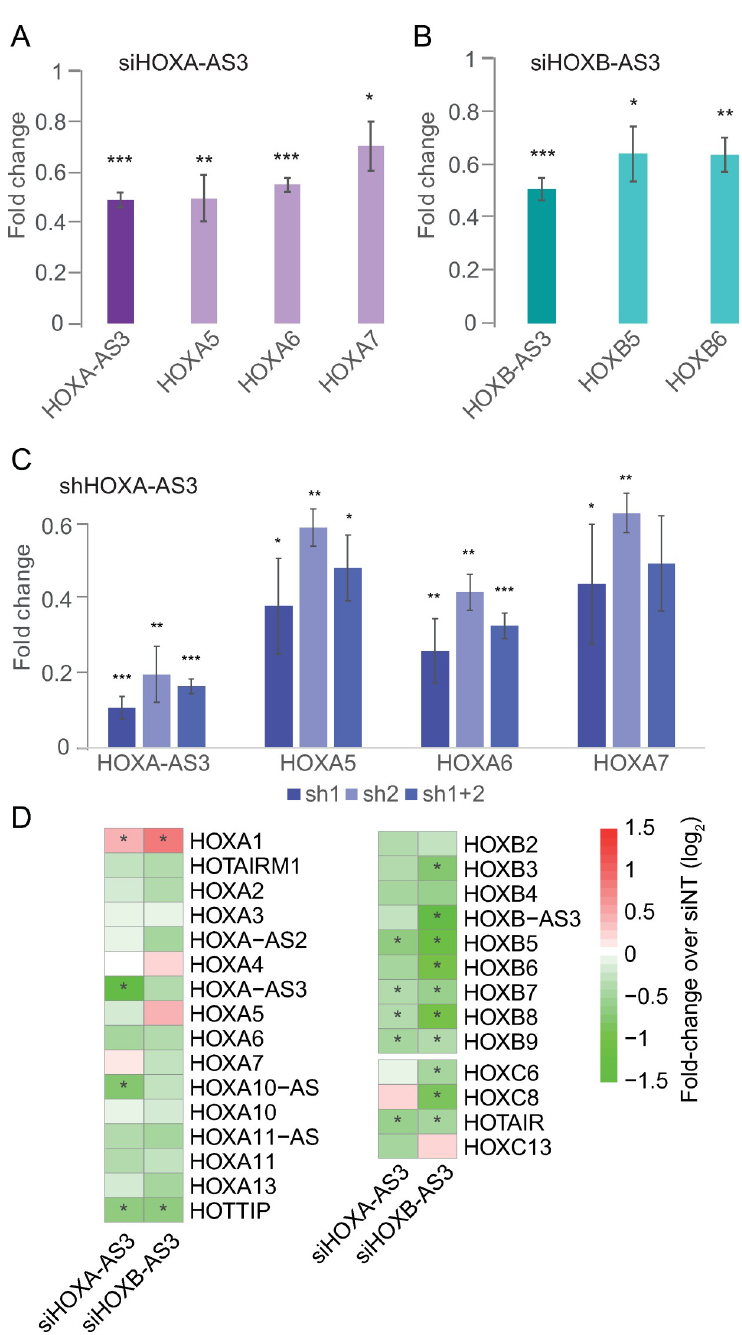
Fig 4. RNA products of HOXA-AS3 and HOXB-AS3 are required for regulation of their adjacent Hox genes. (A-C) qRT-PCR measurements of the indicated genes in HT-29 cells treated with the indicated reagents. Normalized to Actin. n = 4 for siHOXA-AS3 and siHOXB-AS3. n = 3 for shHOXA-AS3. � —P < 0.05, �� —P < 0.005, ��� —P < 0.0005. Two-sided t-test compared to the transfection control. (D) Changes in gene expression in RNA-seq data of HT-29 cells treated with HOXA-AS3 or HOXB-AS3 siRNAs. Shown are HOXA-AS3 , HOXB-AS3 , and all other HOX genes with average FPKM � 1. Asterisks indicate adjusted P < 0.05 as computed by DESeq2.